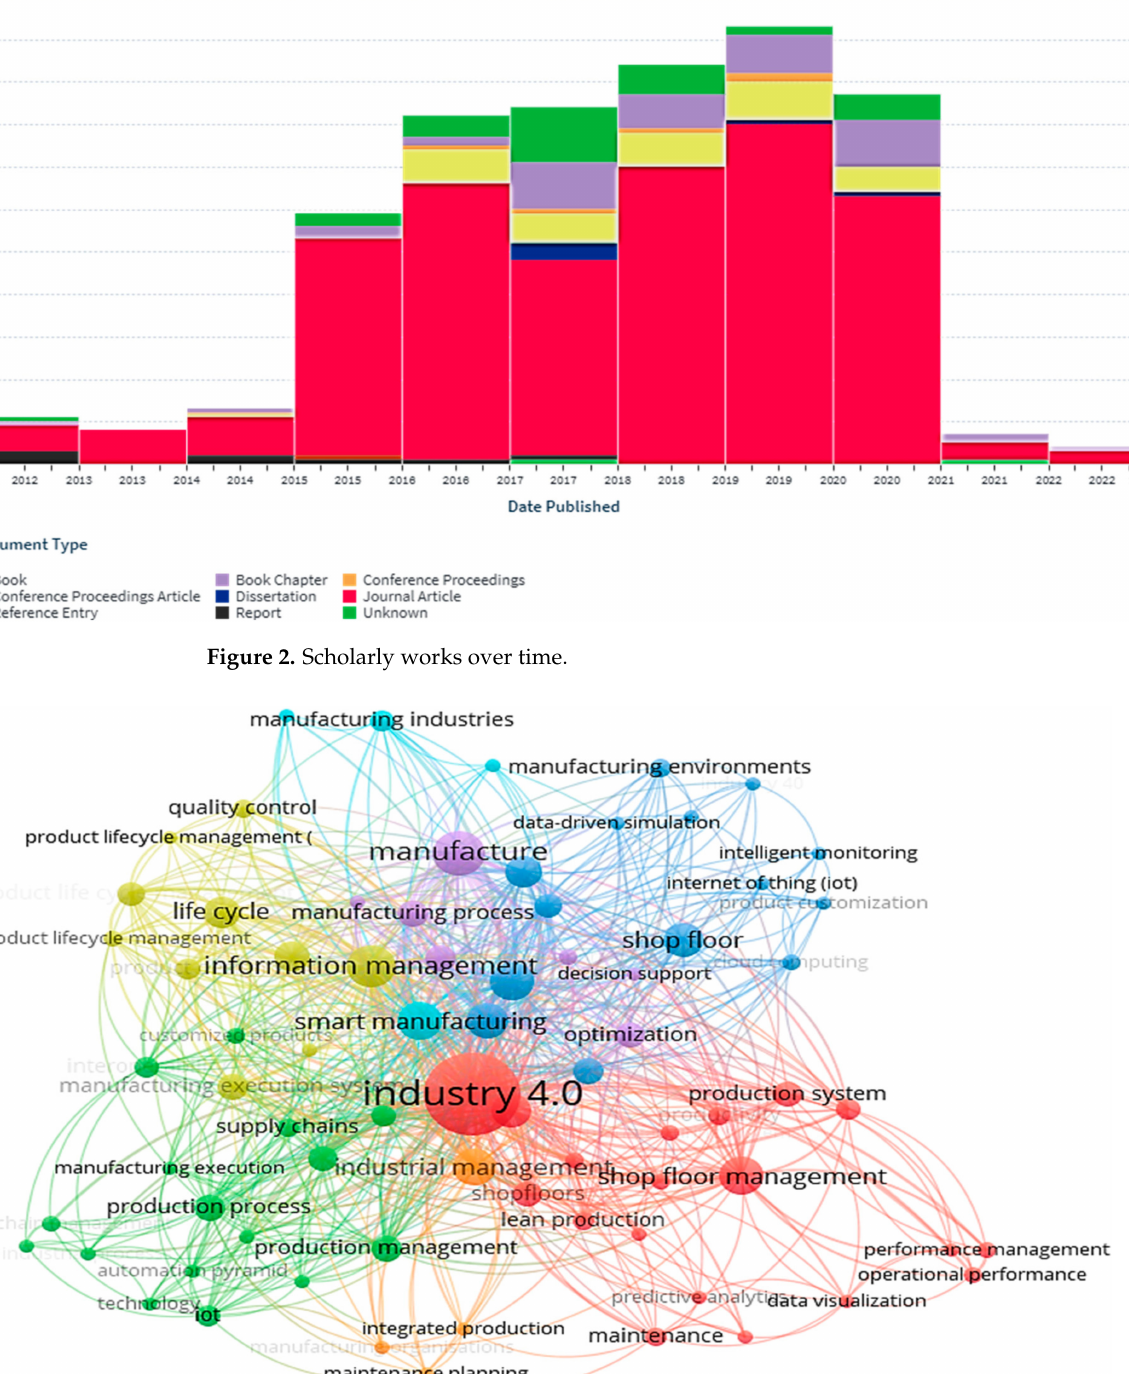
Figure 3. Cluster analysis illustrated industry 4.0 index keywords and key